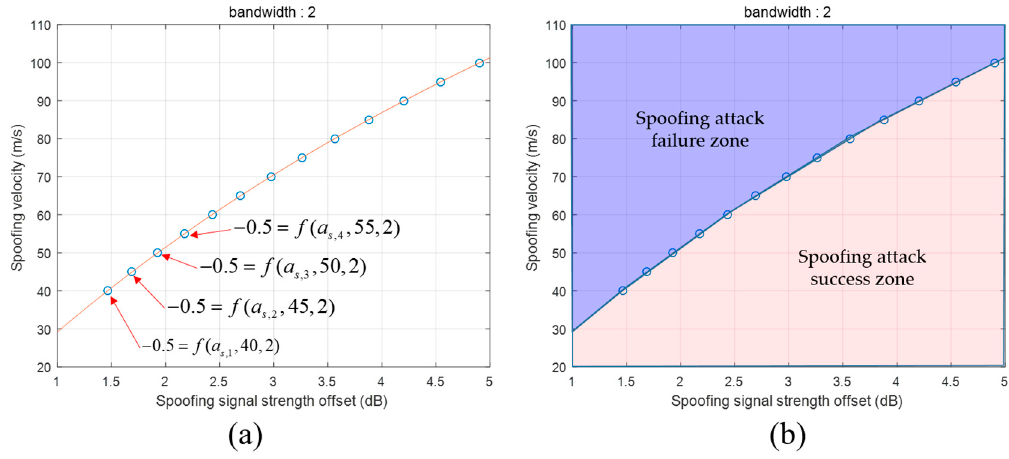
Figure 17. ( a ) a s estimation using SPE; ( b ) Determination of spoofing attack success and failure by boundary line. Table 6. Estimated (cid:101) a s values according to the spoofing